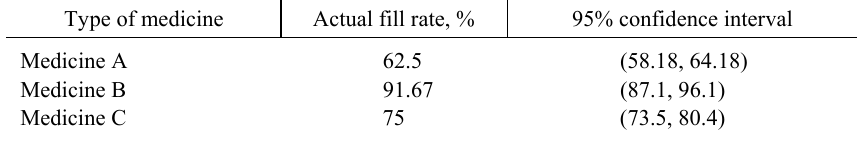
Table 1. Validation test